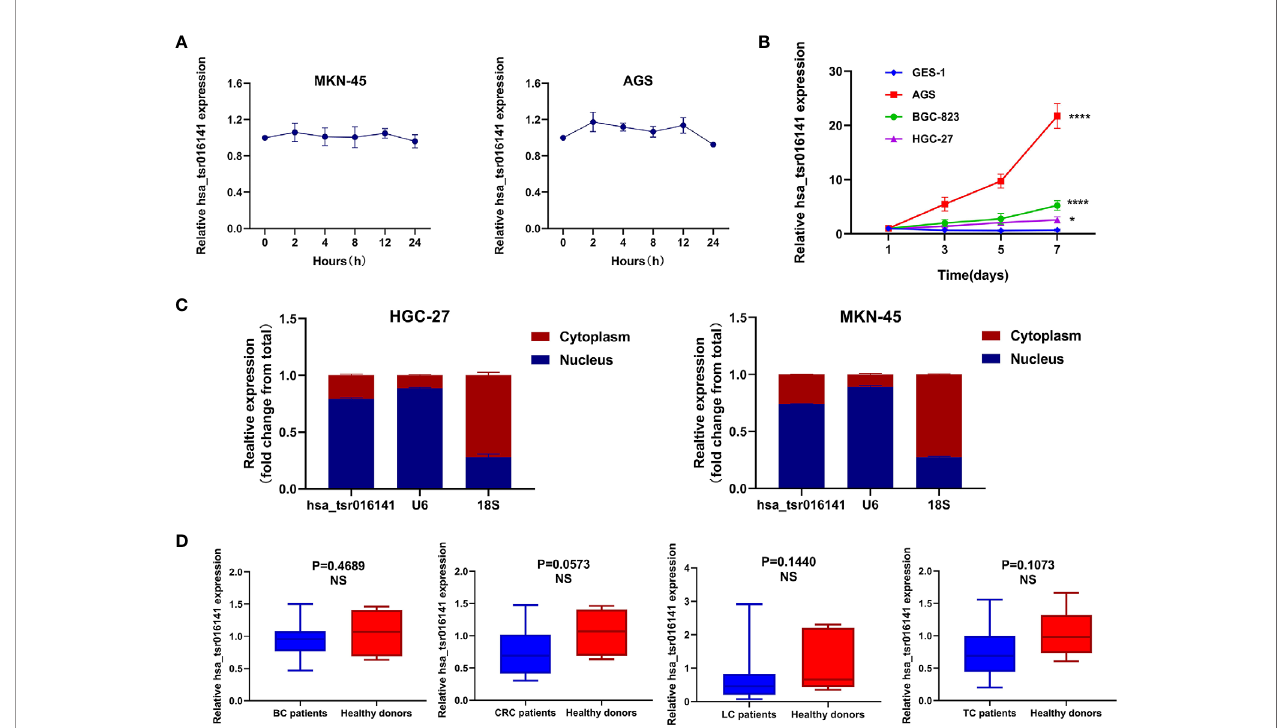
FIGURE 3 | Characterization and advantage of hsa_tsr016141 as a GC biomarker . (A) The good stability of hsa_tsr016141 was con fi rmed by actinomycin D assay. (B) The expression level of hsa_tsr016141 in culture supernatants of AGS and BGC-823 increased with time compared to GES-1. (C) The location of hsa_tsr016141 in HGC-27 and MKN-45 cells was detected by Nuclear and Cytoplasmic RNA Separation Assay. (D) The expression level of hsa_tsr016141 had no signi fi cant difference in other tumors. *P < 0.05, ****P < 0.0001, NS P >